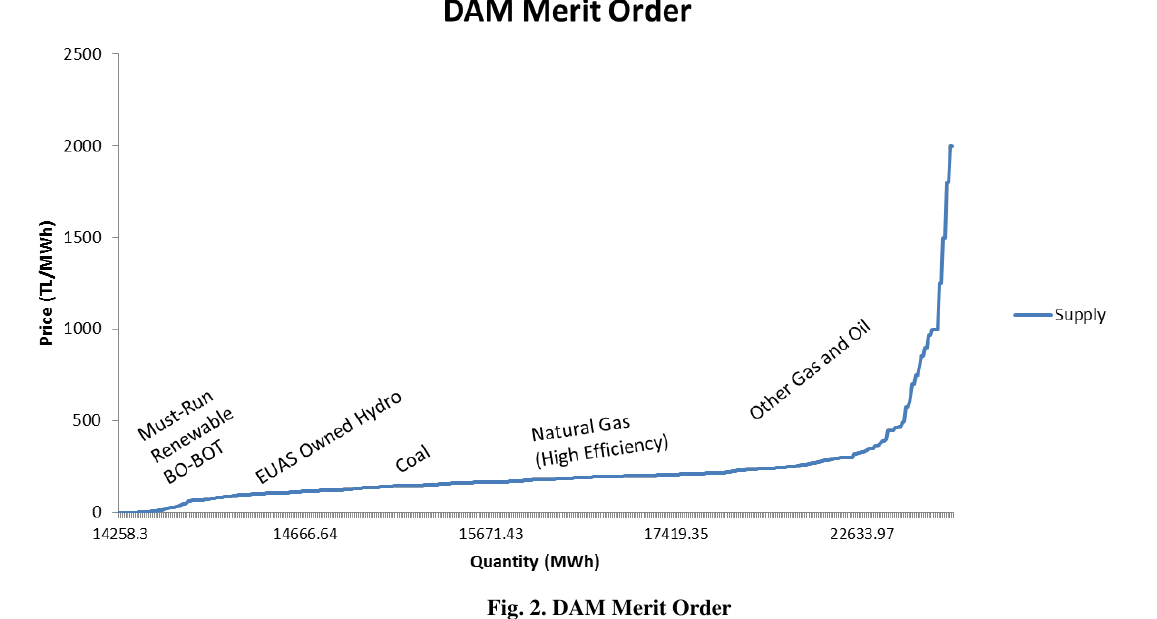
Fig. 2. DAM Merit Order